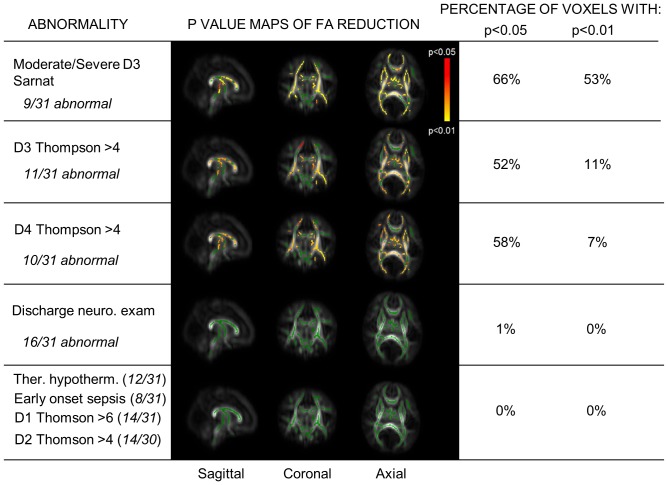
Whole-brain white matter FA according to perinatal clinical assessment.p value maps are displayed as described in Figure 2. Neuro = neurological; Ther. hypotherm. = therapeutic hypothermia.